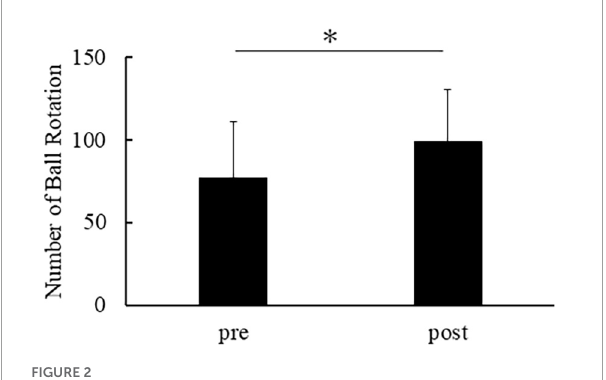
FIGURE2 Number of ball rotations in pre and post. The horizontal axis indicates the number of ball rotations. The error bar indicates the standard deviation. Asterisks indicate significant differences ( p <